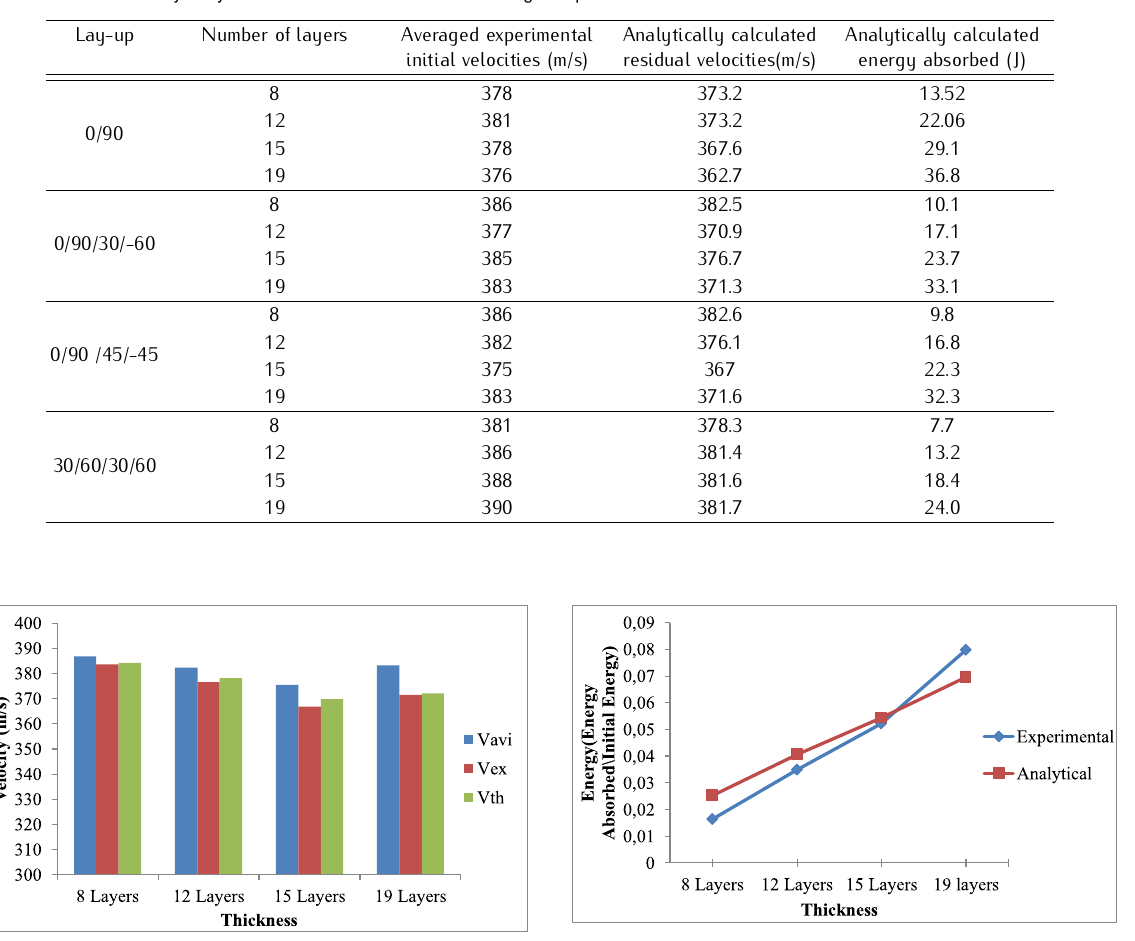
Figure 21. Comparison chart for variation in dimensionless param- eter with thickness of plates for 0/90 lay-up obtained analytically and